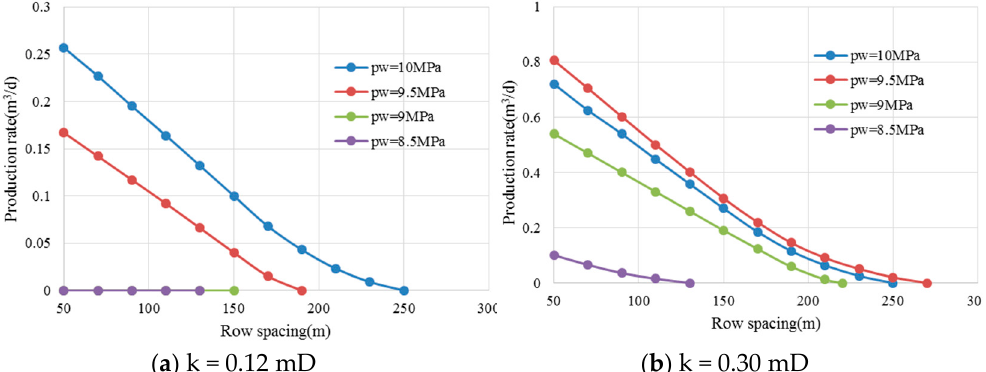
Figure 22. The relationship between the production rate and the row spacing.